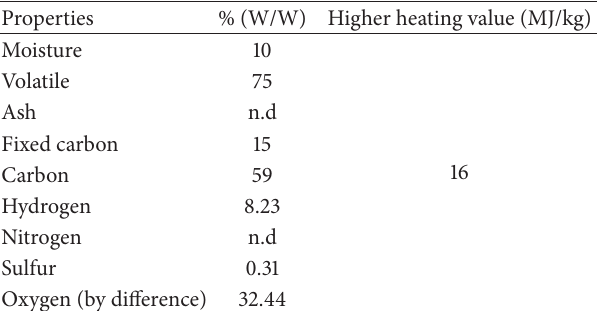
Table 1: Results of proximate and ultimate analyses and higher heating value of newspaper.